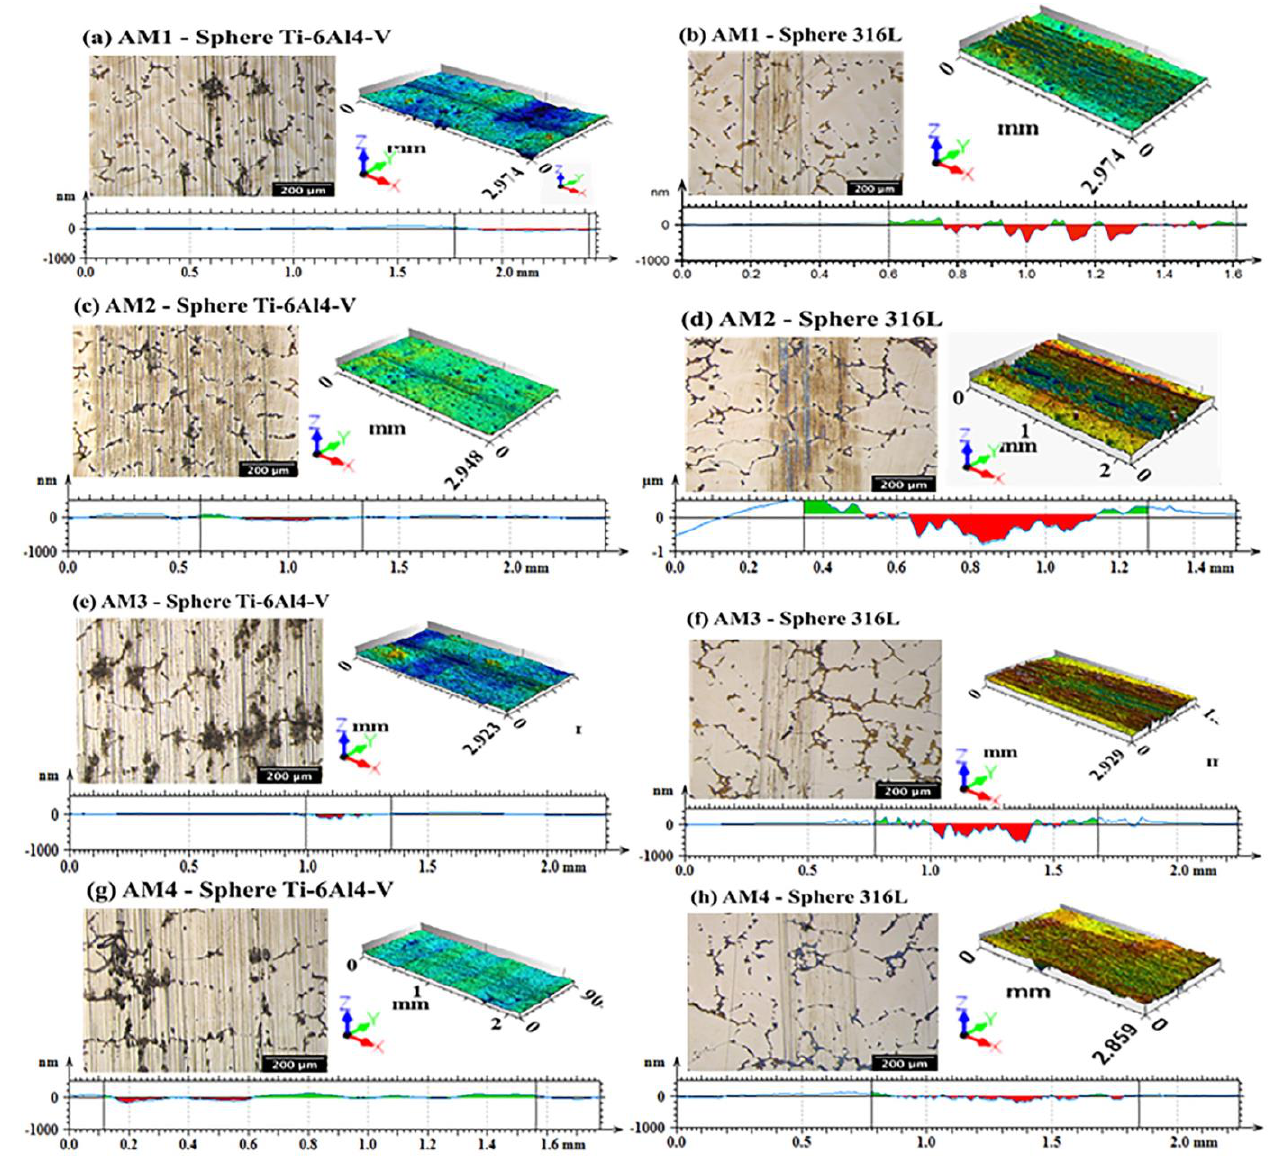
Figure 10. Images obtained from 3D profilometer analysis of eight cross-section wear tracks of Co-Cr-Mo samples AM1, AM2, AM3, and AM4, together with the corresponding depth profiles obtained using the interferometry technique